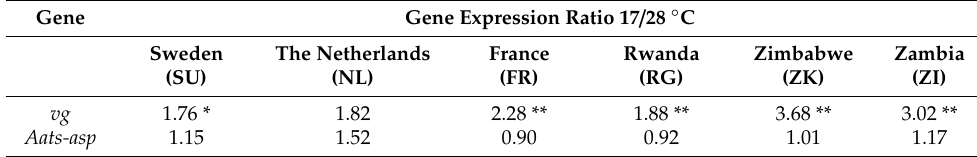
Table 3. Fold-changes in gene expression between rearing temperatures in adult D. melanogaster . Gene Gene Expression Ratio 17 / 28 ◦ C Sweden The Netherlands France Rwanda (SU) (NL) (FR)